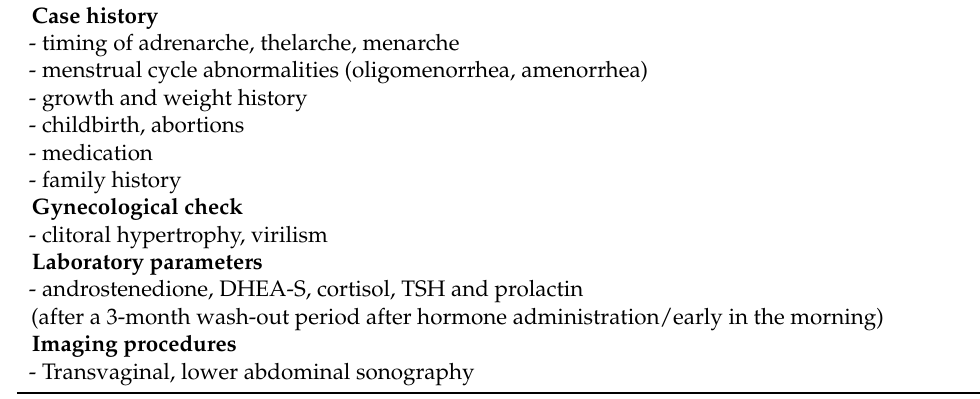
Table 2. Diagnostic approach and endocrinological evaluation in suspected hyperandrogenemia.